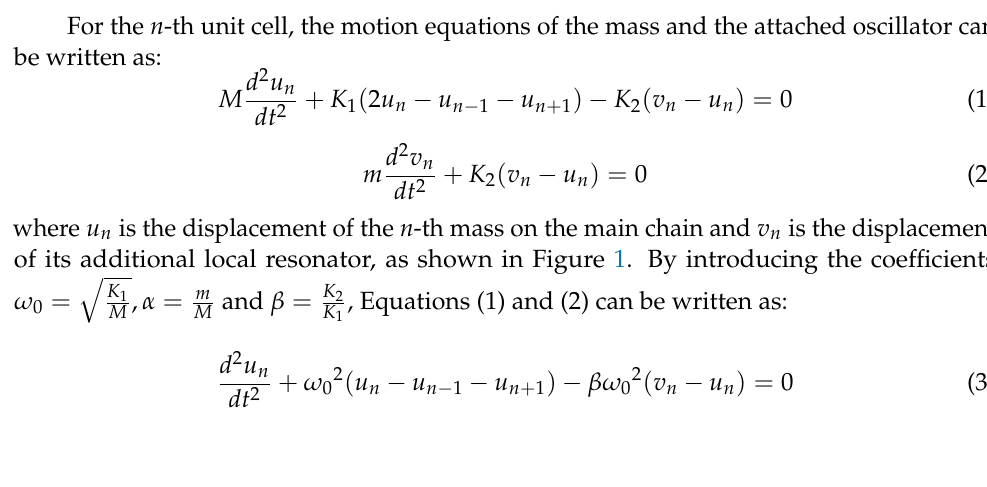
Figure 1. Linear one-dimensional mass-spring lattices attached with local